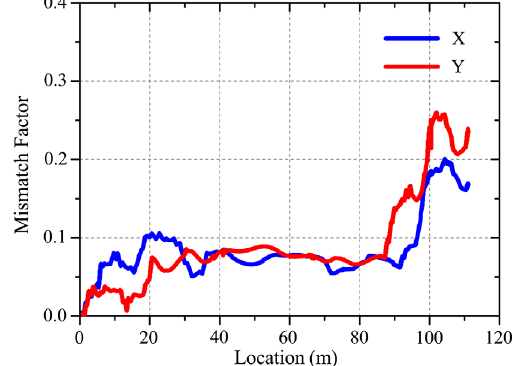
FIG. 9. Mismatch factor evolution of the single-bunch simu- lation and the simulation including multiple collisions through the double-pass linac.